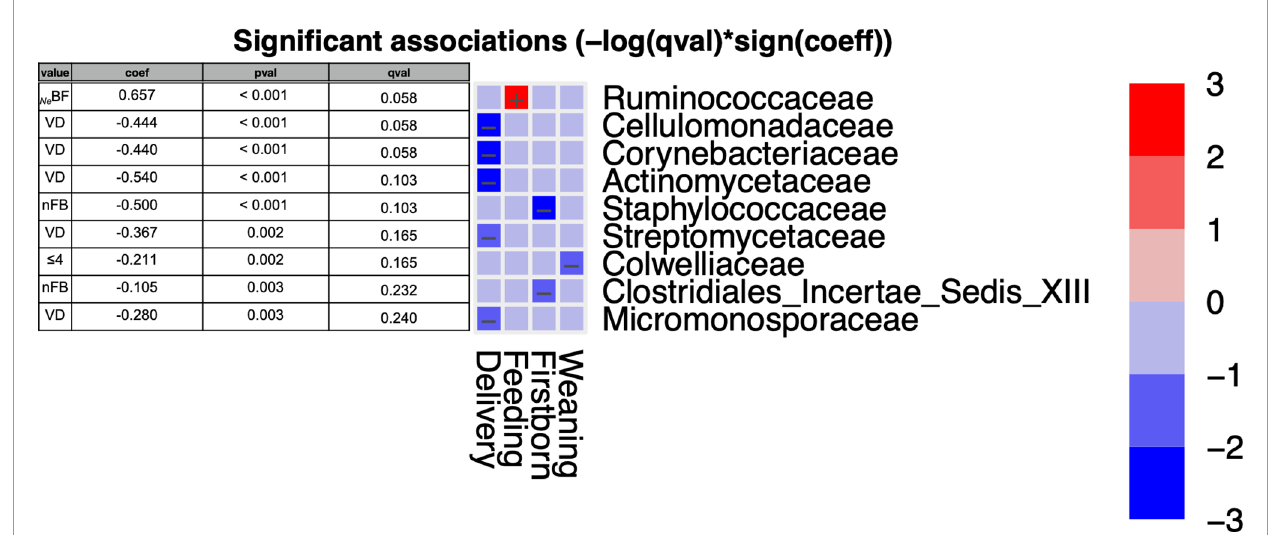
FIGURE 3 | MaAsLin2 signi fi cant results and associations between postnatal factors (delivery, feeding, weaning, and presence of older siblings) and gut microbiota composition at the family level of infants at six months of age (T2). Based on normalized obtained signi fi cant results, the color scale-bar showed a positive relationship (red) and a negative one (blue) between taxa and factors, ranging from the highest positive normalization (+3) to the lowest one ( − 3).